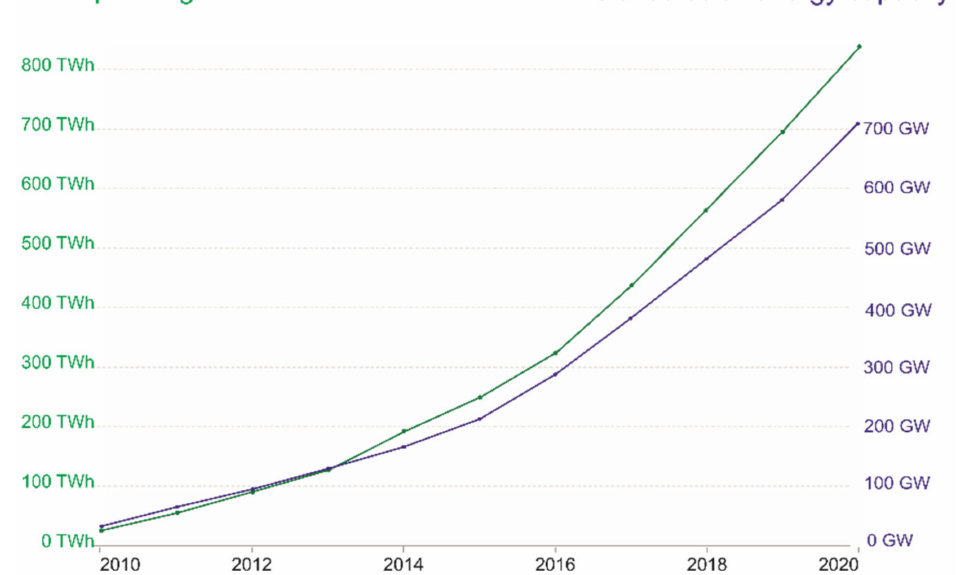
Figure 1. Global trends in the last decade: cumulative installed solar energy capacity (blue); electricity generation from solar